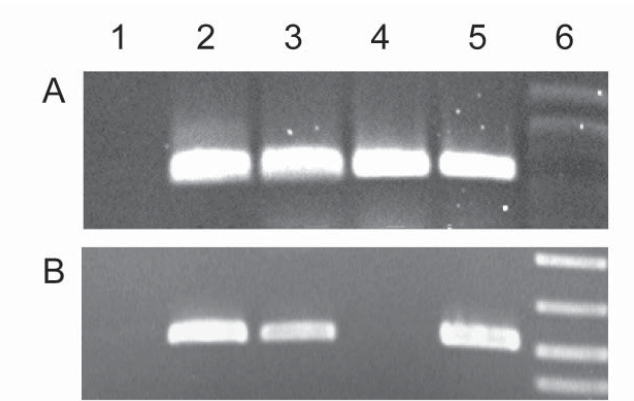
Fig. 1. PCR amplification of pCT74 transformants with hygromycin B phosphotransferase ( hph ) primers (A) or green fluorescent protein ( gfp ) primers (B) and templates of genomic DNA from wild-type Eutypa lata E10-10 (lane 1), pCT74 control plasmid (lane 2), E. lata pCT74 trans- formants S6, S4, S1 (lanes 3–5 respectively). Lane 6 contains a size marker ladder (Invitrogen 1 kb+). Sizes of PCR products are 360 bp in A and 520 bp in B.